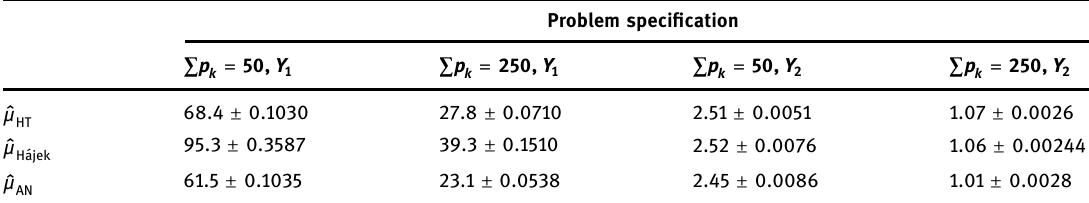
Table 1: RMSE of estimators on Swiss municipality data; Y 1 is wood area and Y 2 is industrial area; probabilities are chosen proportional to total municipality area, which is strongly positively correlated with Y 1 and weakly positively correlated with Y 2 . RMSEs are averaged over 100,000 trials and standard errors are over 10 replications of the 100,000 trials